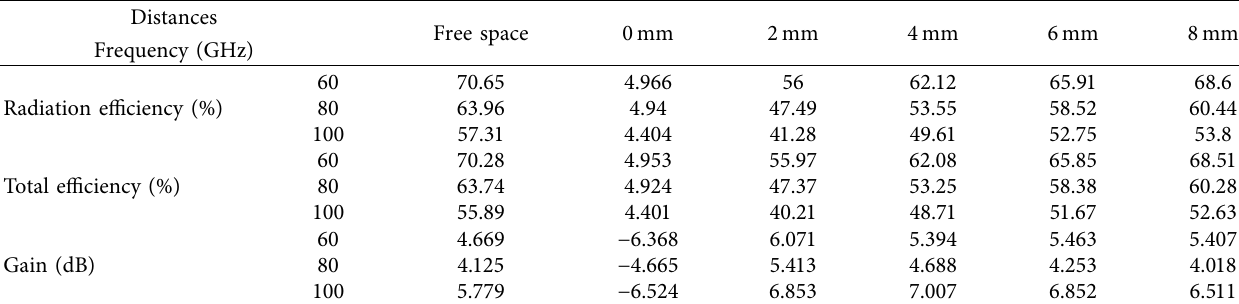
Figure 13: VSWR at various distances from the human body and in free space. Table 6: Gain and efficiency